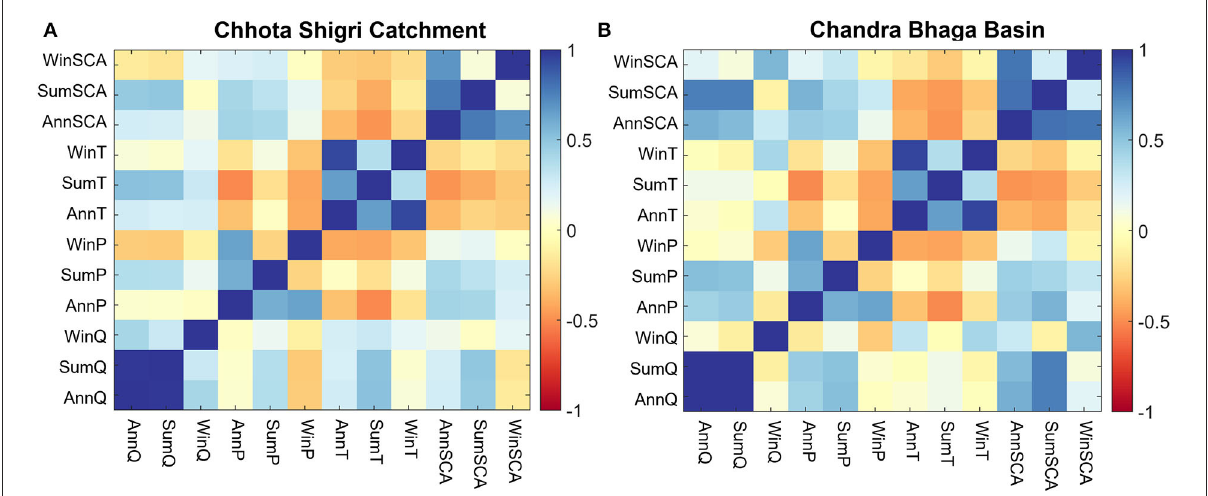
FIGURE9 Correlation matrix for Chhota Shigri Catchment (A) and Chanda-Bhaga Basin (B) . The values from − 1 to 1 denote the correlation coefficients and the color range denotes the intensity of the correlation (one denotes the completely positive correlation, dark blue, and − 1 denotes the completely negative correlation, dark brown). Ann, Sum, and Win are annual, summer, and winter season and Q, P, T, and SCA are discharge, precipitation, temperature, and SCA, respectively.